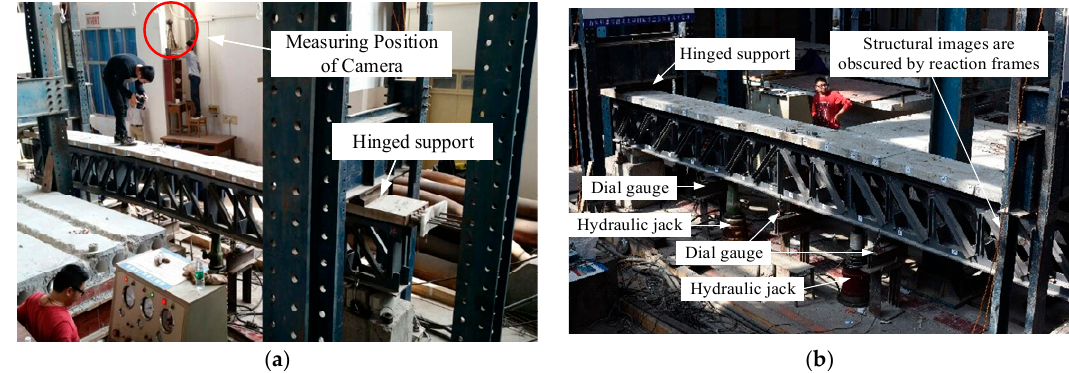
Figure 7. Field layout of static load test; ( a ) camera placement position; ( b ) collecting shape data of experimental beam.